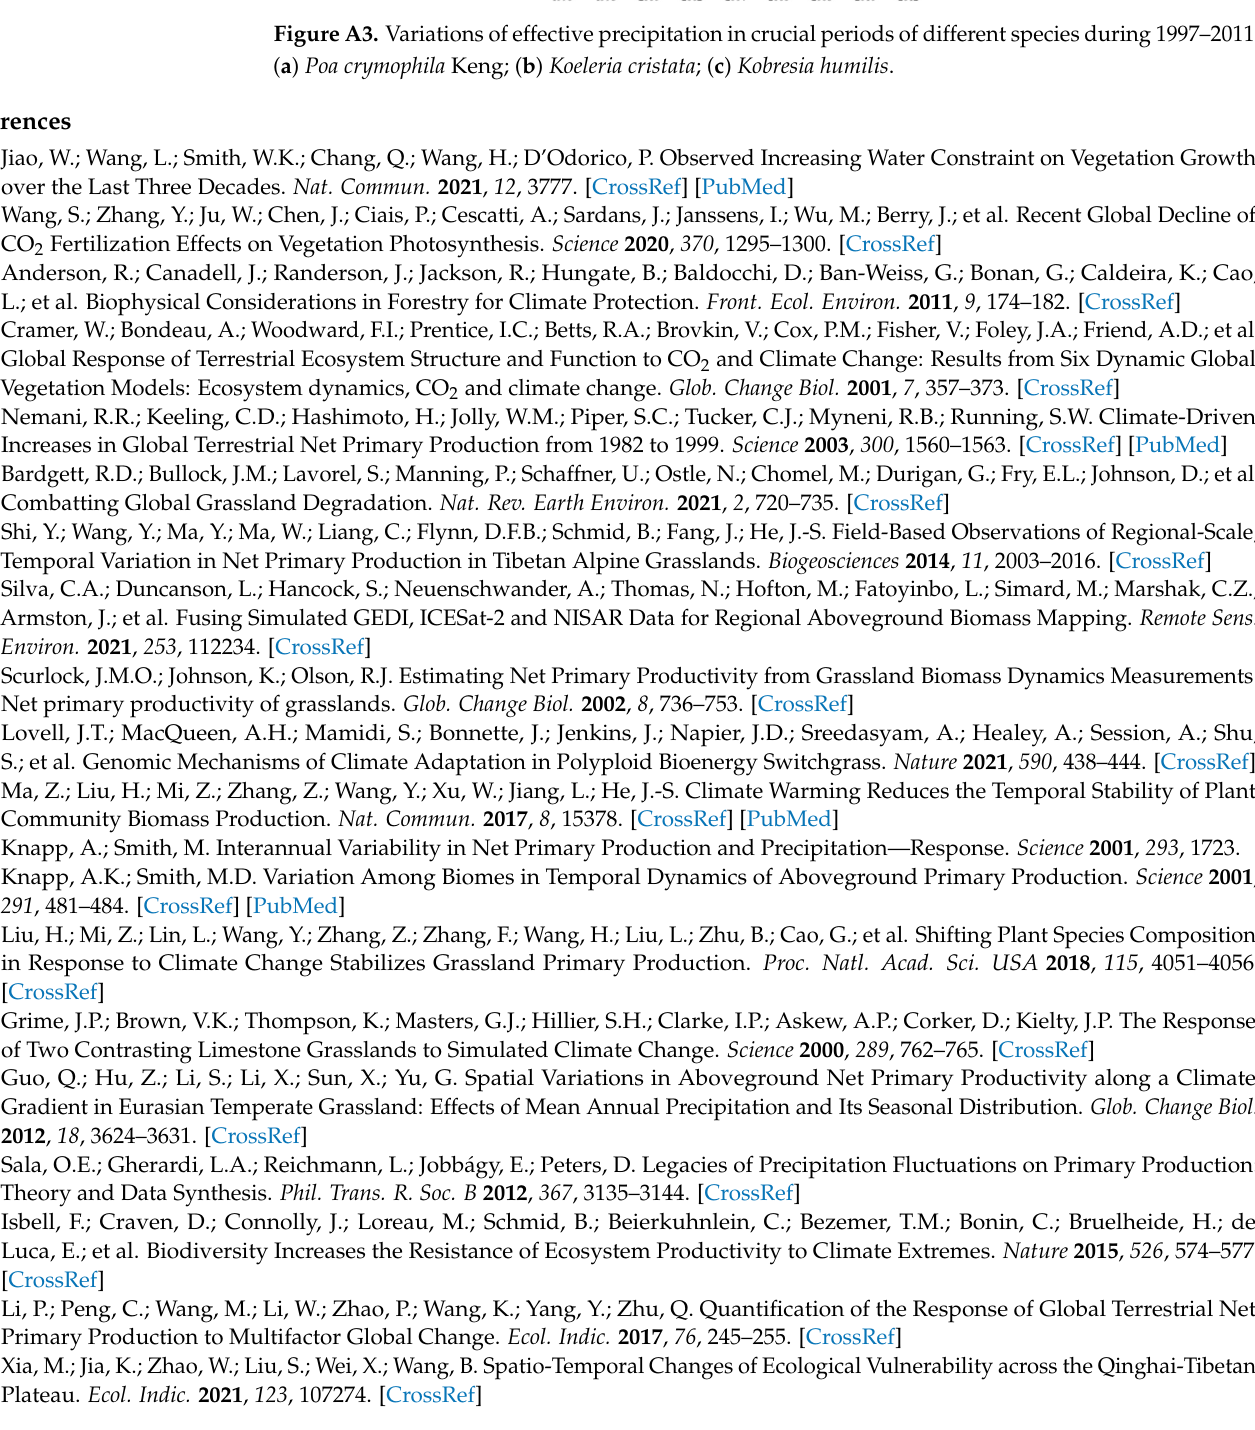
Figure A3. Variations of effective precipitation in crucial periods of different species during 1997–2011. ( a ) Poa crymophila Keng; ( b ) Koeleria cristata ; ( c ) Kobresia humilis .